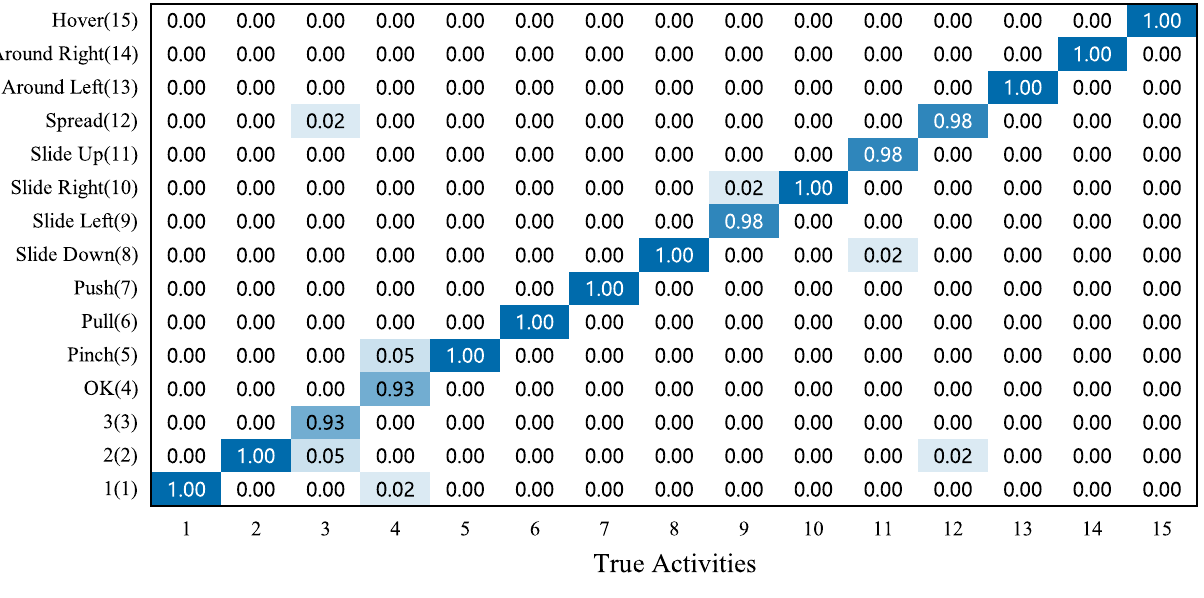
Figure 12. Overall performance of single